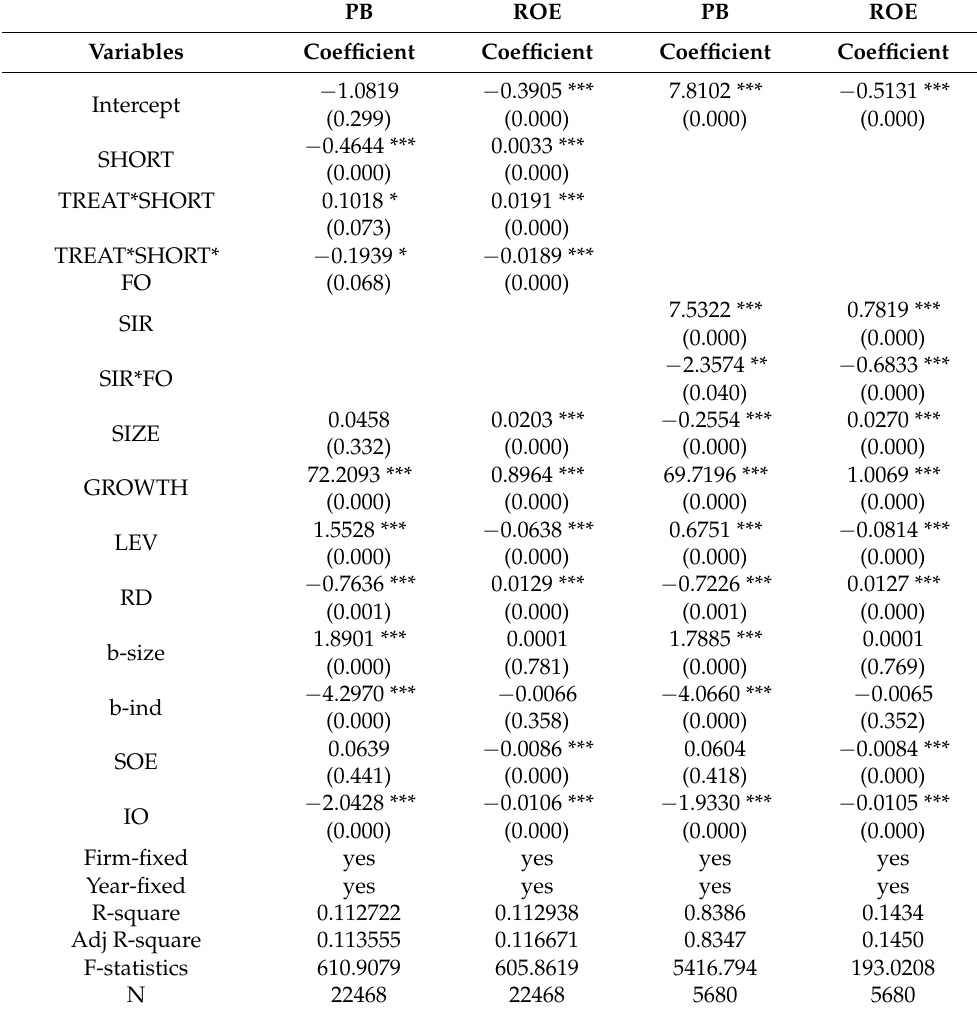
Table 9. Robustness test for alternative measurements of firm value.